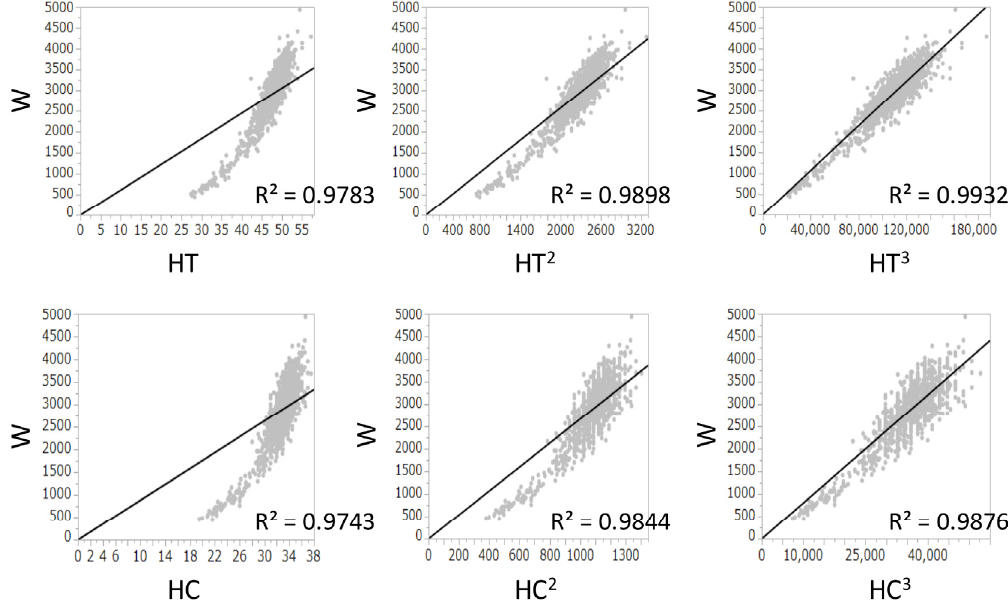
Figure 1. Linear regression analyses between birth weight and height, (height) 2 , or (height) 3 and between birth weight and head circumference, (head circumference) 2 , or (head circumference) 3 at birth. R 2 , coefficients of determination; HC, head circumference; HT, height; W, birth weight.